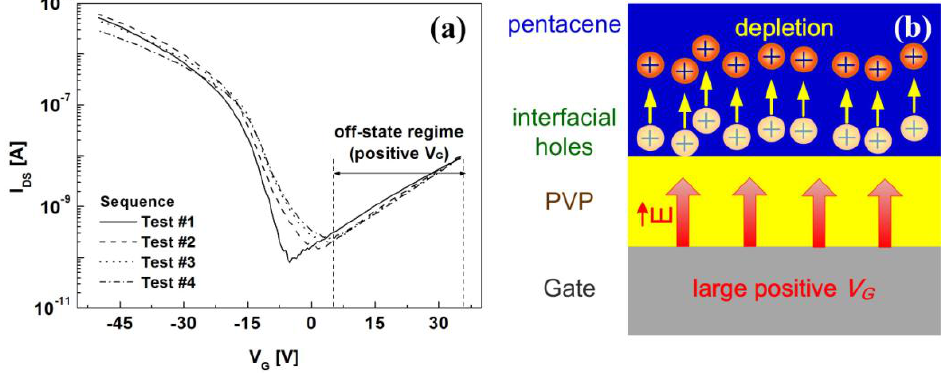
Figure 6. (a) Transfer characteristics of the OTFT with the PVP layer. (b) Schematic diagram of the depletion mechanism of interfacial holes by a large positive gate